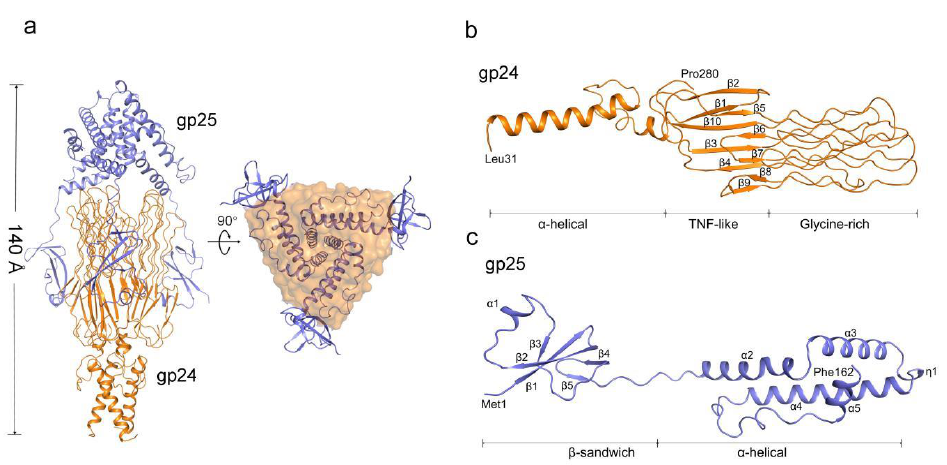
Figure 2. Overall structure of the gp24-gp25 complex. ( a ) Overall structure of the gp24-gp25 complex shown in side and bottom views. The structure of gp25 is shown in cartoon and colored blue. The structure of gp24 is colored orange and shown in cartoon and surface, respectively, in the two views. Cartoon representation of one subunit of gp24 ( b ) and gp25 ( c ). The distinct domains, the secondary structural elements and the terminal residues are labeled.